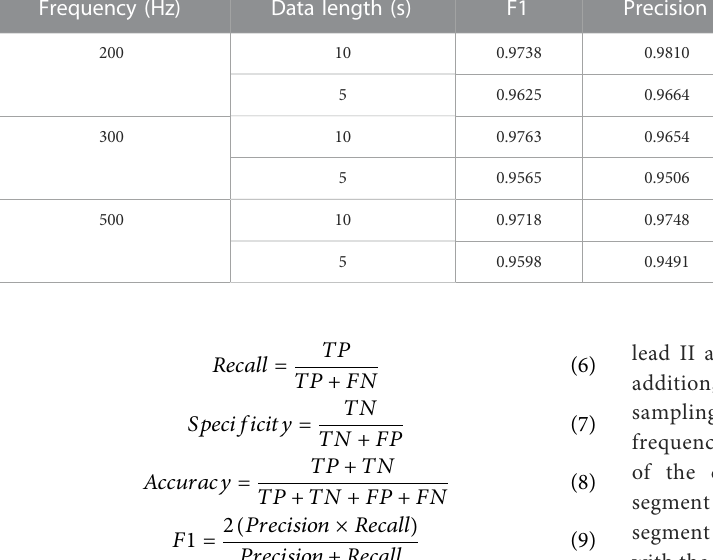
TABLE 2 Performance of AF classi fi cation based on different frequencies and data lengths. Frequency (Hz) Data length